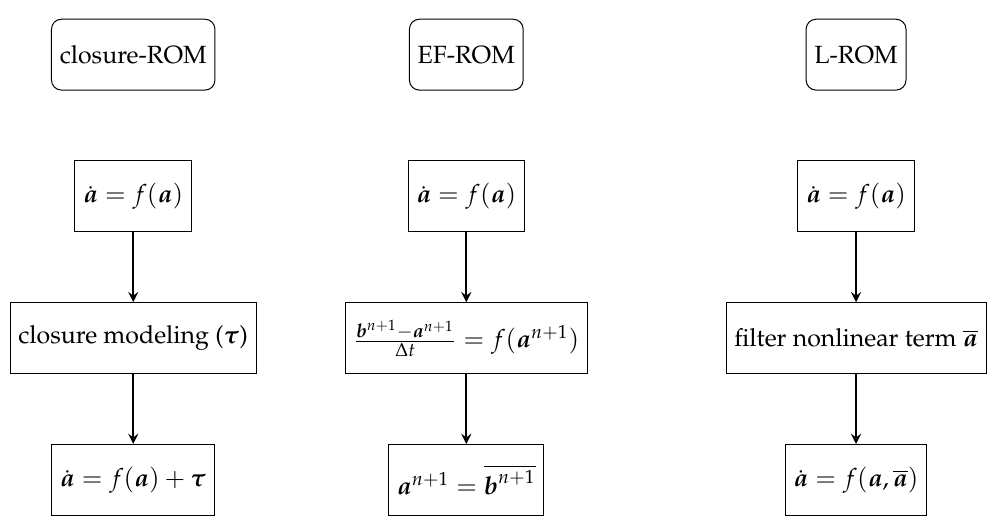
Figure 1. Reduced order model (ROM) closure modeling, volve-then-filter reduced order model (EF-ROM), and leray-regularization reduced order model (L-ROM) flowcharts.